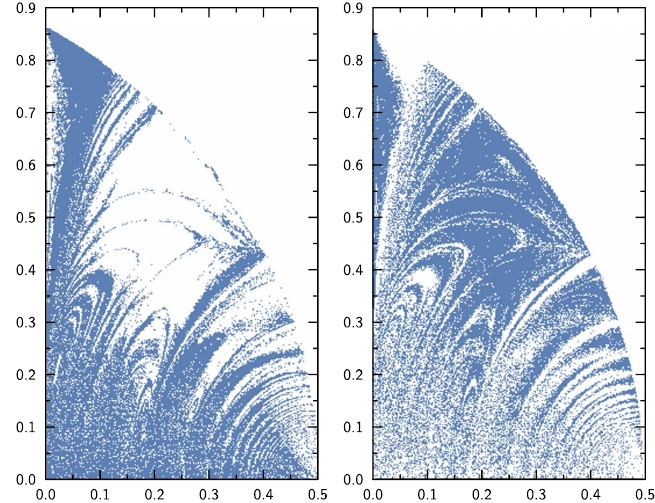
Fig. 8. Initial conditions corresponding to the two modes in the histogram shown in the right panel of Fig. 7.